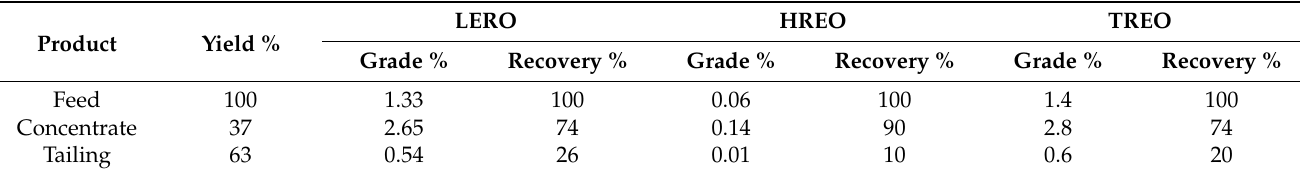
Table 3. Results of physical separation through Wilfley shaking table.